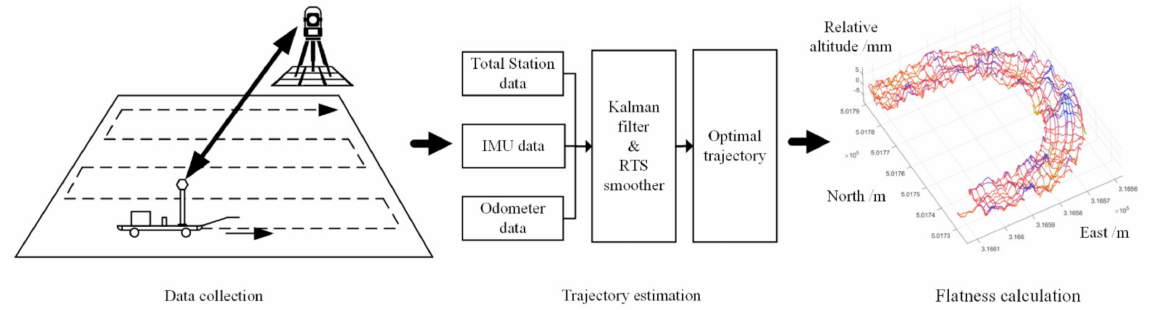
Figure 2. Framework of large-floor flatness inspection by wheeled robot with aided INS.